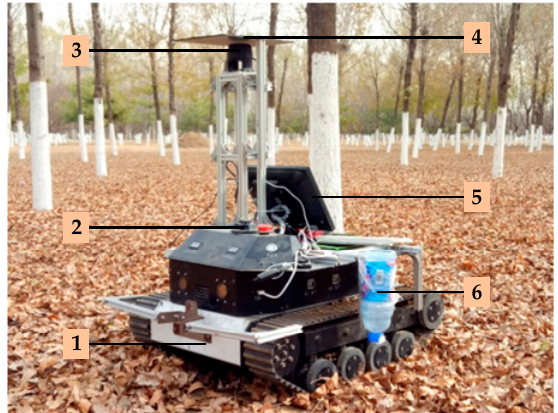
Figure 1. The Robot System. 1. Car body; 2. Gyroscope; 3. LiDAR; 4. Shading board; 5. Display screen; 6. Tracing device.